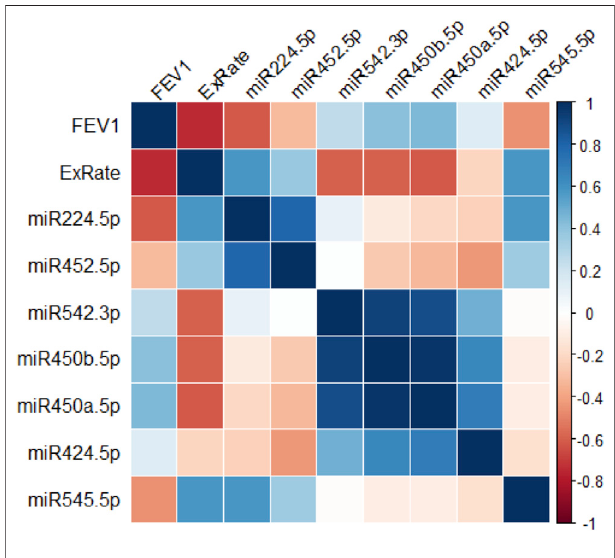
FIGURE 2 | X-linked miRNA expression, lung function and exacerbations. Correlogram of the relationships between levels of top 7 altered X-linked miRNA in peripheral blood monocytes and lung function parameters in people with CF ( n (cid:1) 12). r values are depicted as a color scale ranging from red ( − 1) to blue